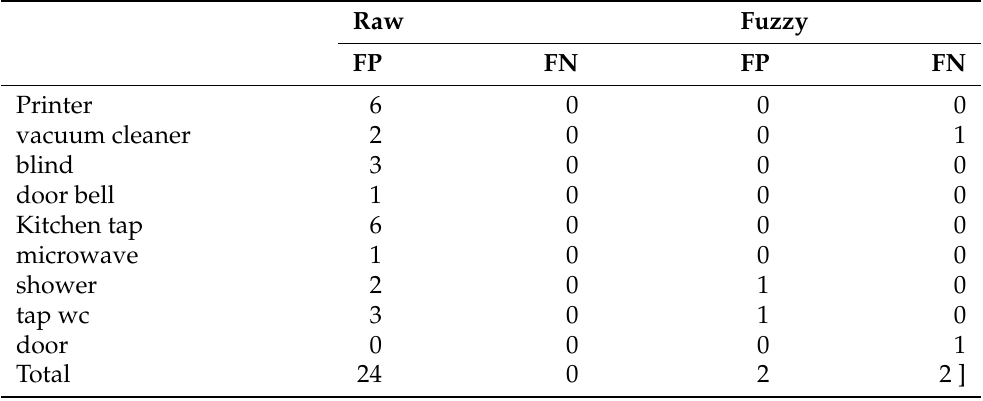
Table 8. False positives (FP) and negatives (FN) computed from the time interval detection of home events using raw processing and fuzzy temporal